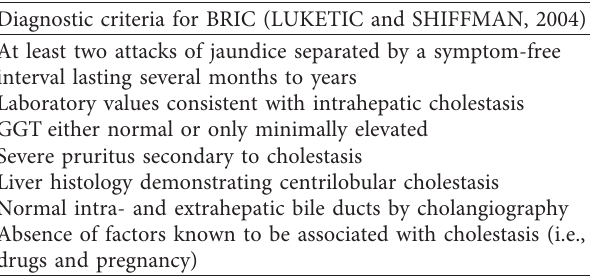
Figure 1: Liver histology. (a) Liver architecture is preserved. No inflammation, steatosis, or fibrosis seen (haematoxylin and eosin (H&E) × 100). Intrahepatic cholestasis predominantly in the centrilobular zone is identified (black arrows). (b) Intrahepatic cholestasis (black arrows) better demonstrated at a higher magnification (H&E × 400). Central vein at the middle. Table 3: Diagnostic